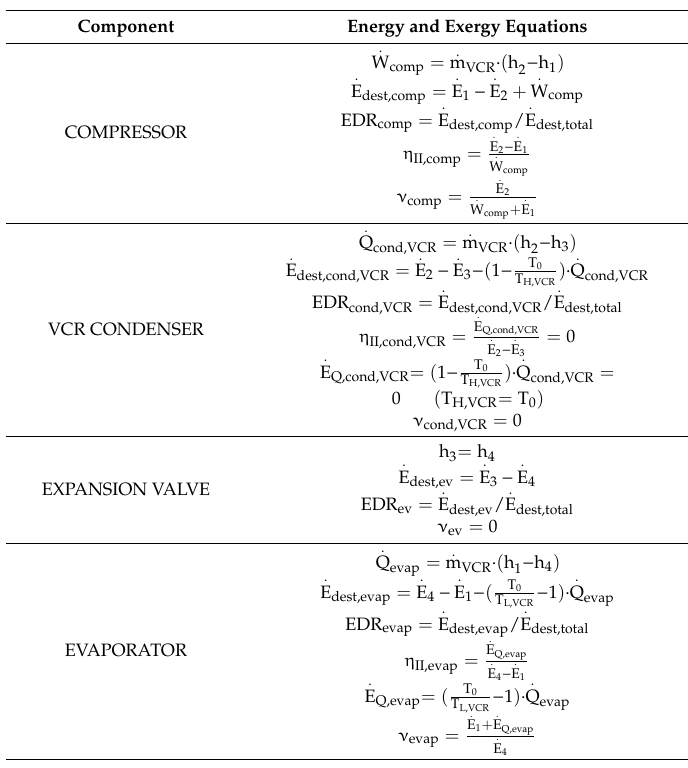
Table 4. Equations for VCR cycle components in combined ORC-single evaporator VCR cycle.